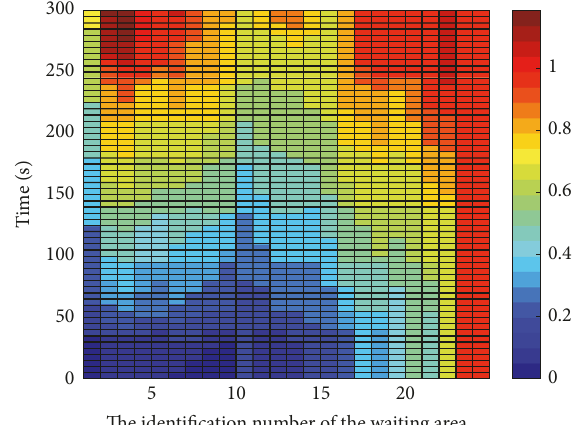
Figure 15: The pseudo-color map of the variation of passenger density with time at each waiting